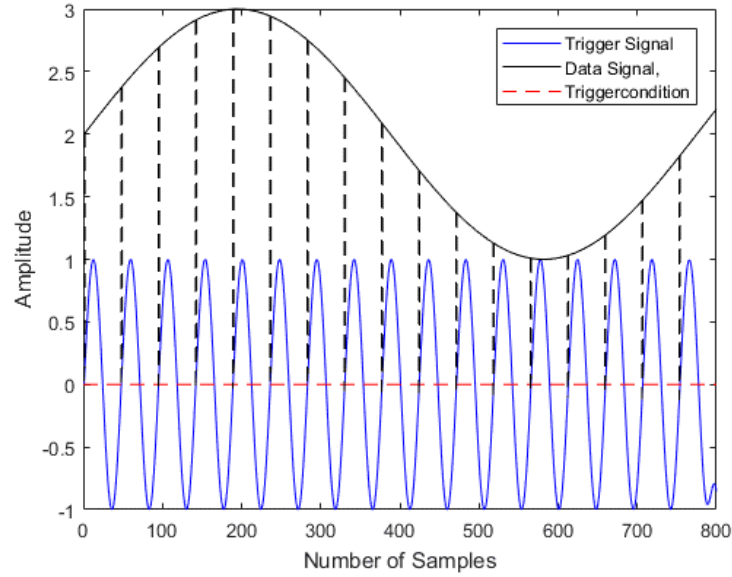
Figure 3. Schematic diagram of the trigger after interpolation.